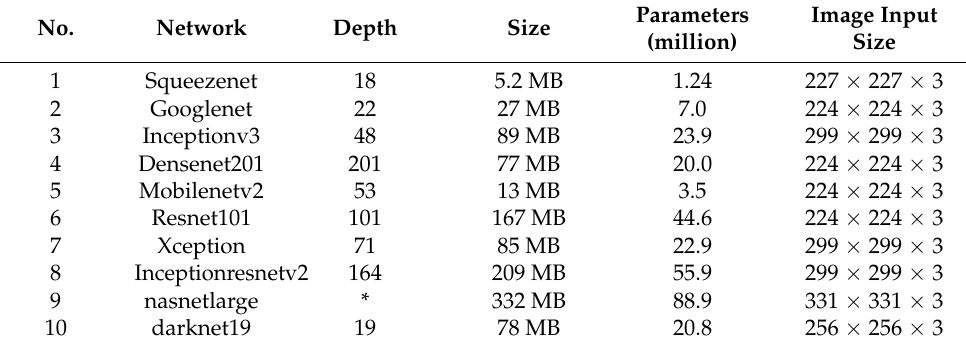
Table 4. Overall view of the transfer learning models used in this study.